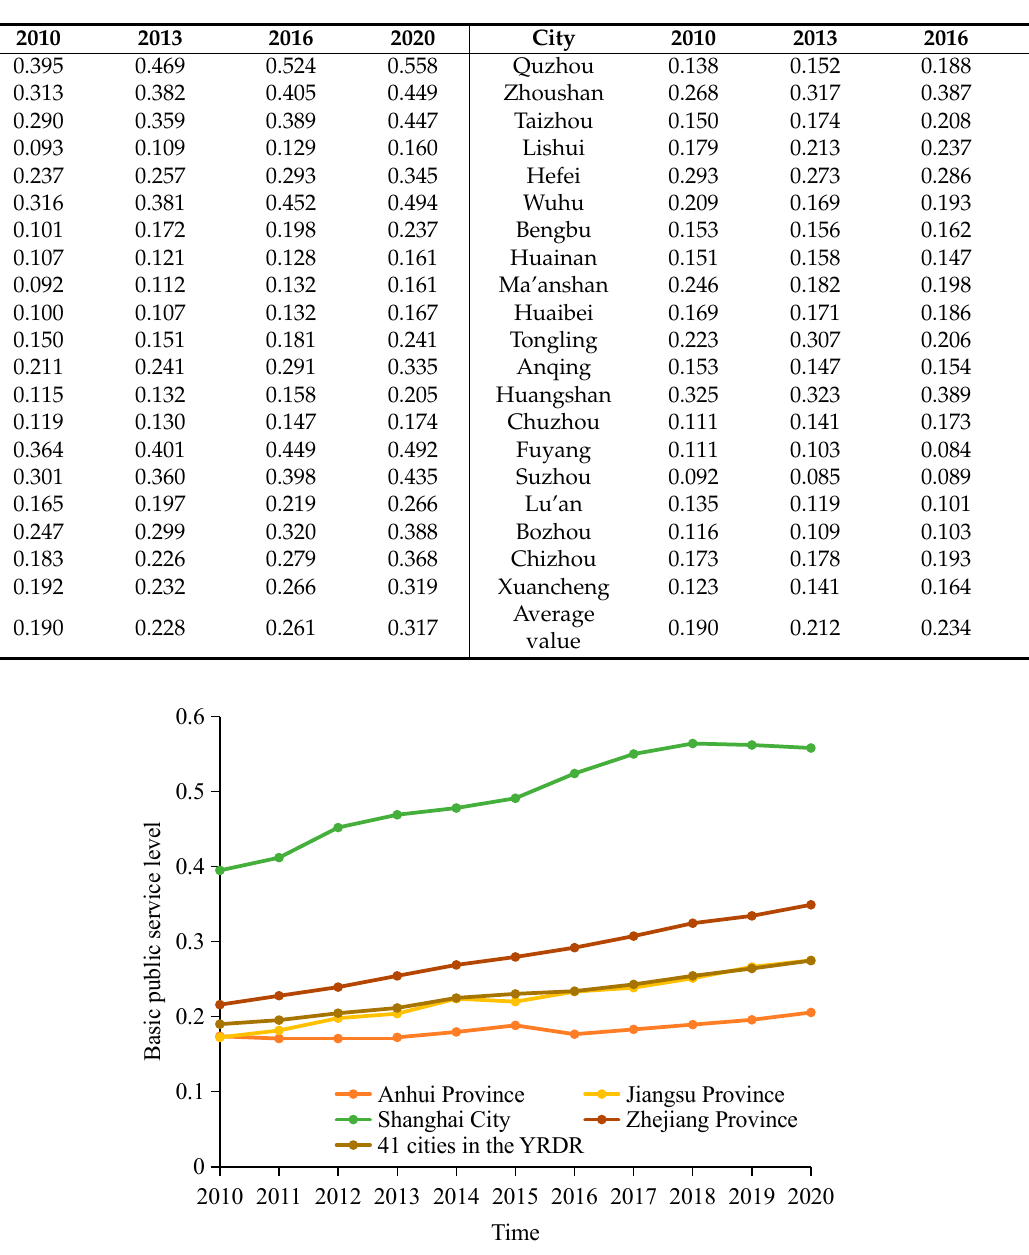
Table 2. Estimation results of the BPSL in the YRDR from 2010 to 2020.